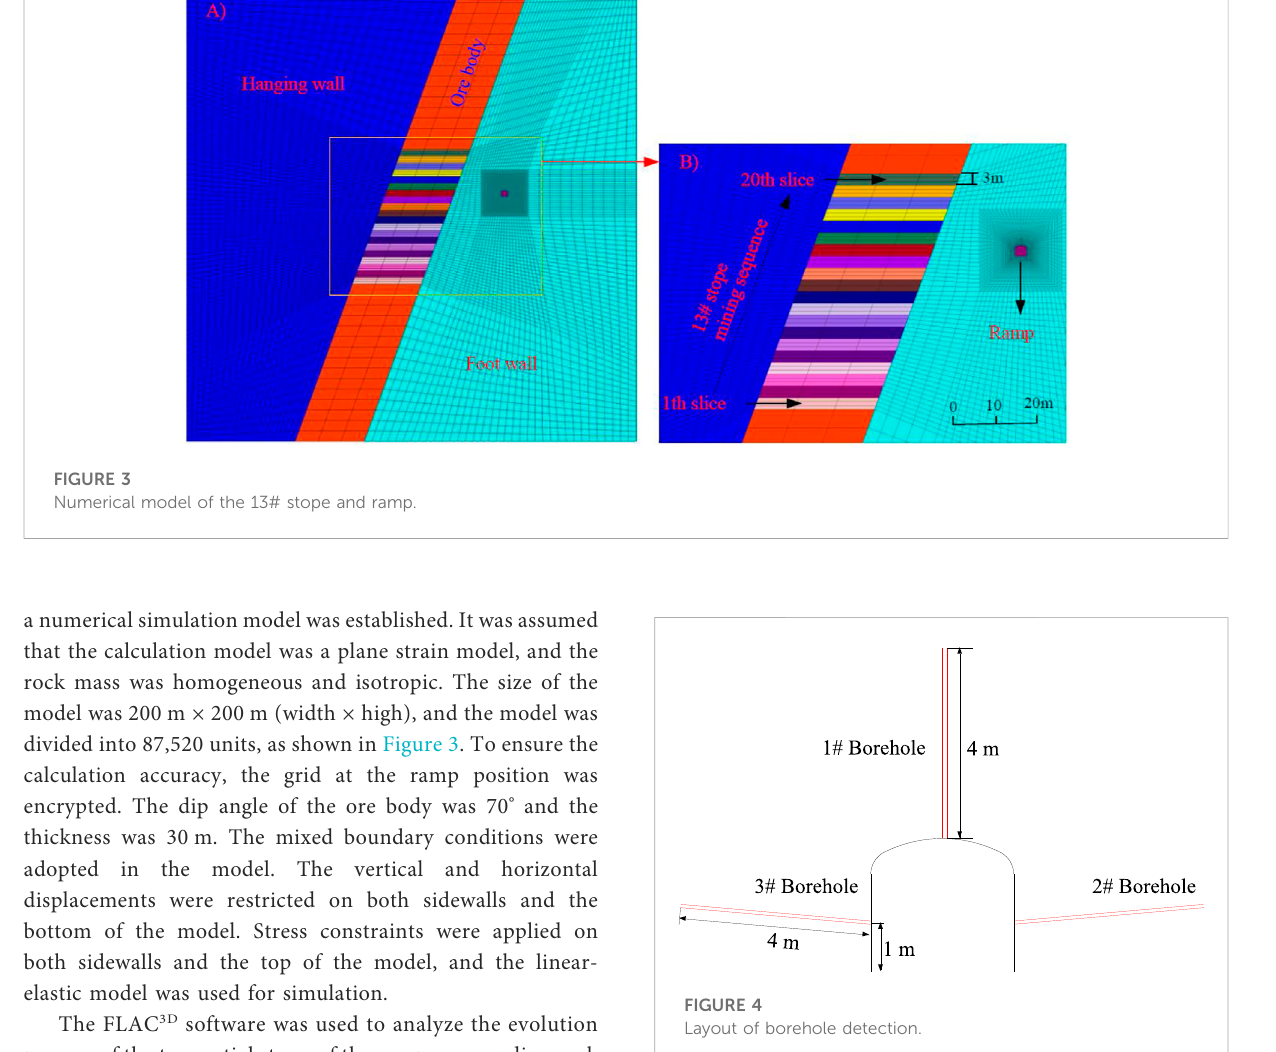
FIGURE 4 Layout of borehole